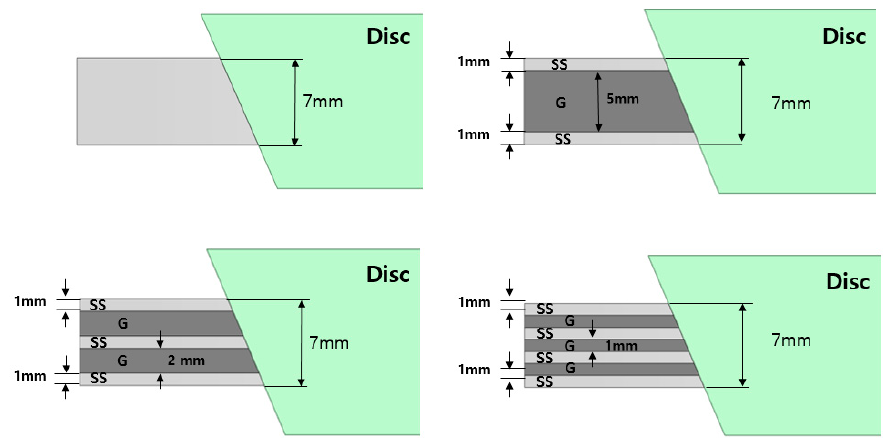
Figure 11. The laminated seal model with di ff erent number of layers.